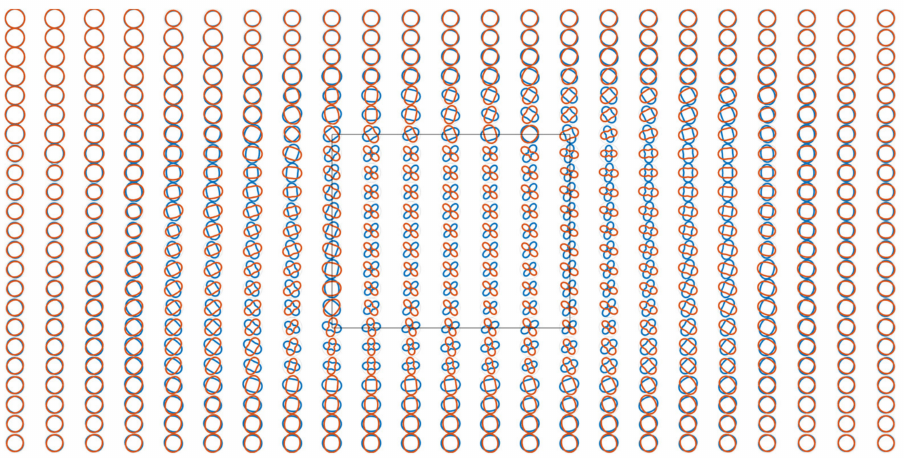
Figure 13. Polar plots of modified COMMEMI 3D-1A model for a frequency of 0.57 Hz. Principal conductivity rotation around the x -, y -, and z -axis by 30 ◦